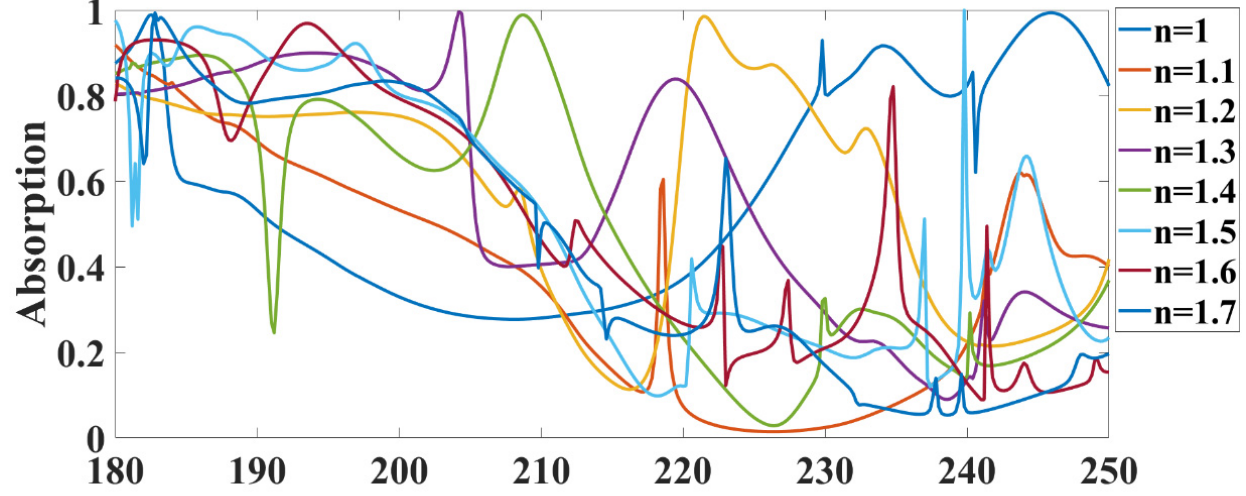
Figure 2. Variation in the absorption for the different refractive index values.